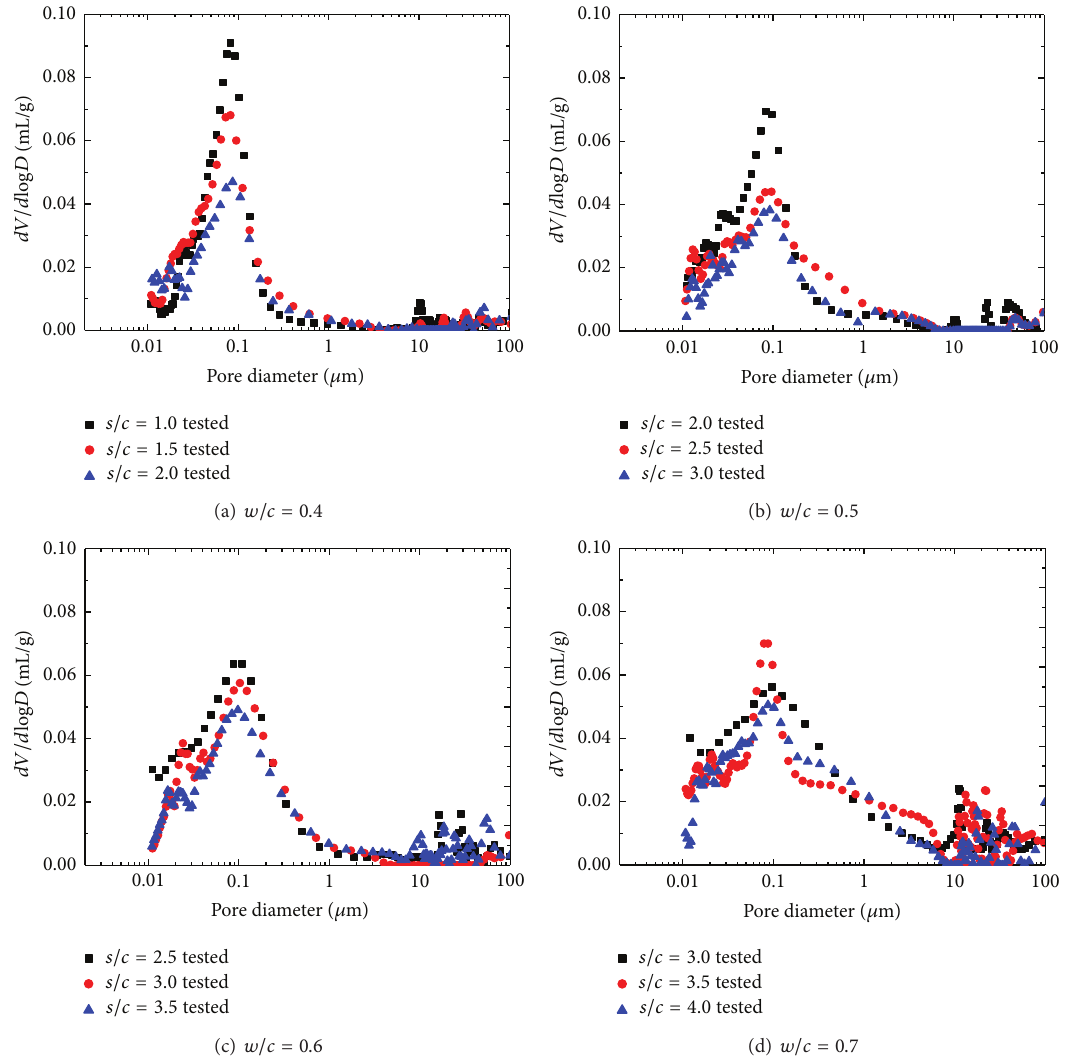
Figure 5: Differential intrudes volume versus pore diameter for NS